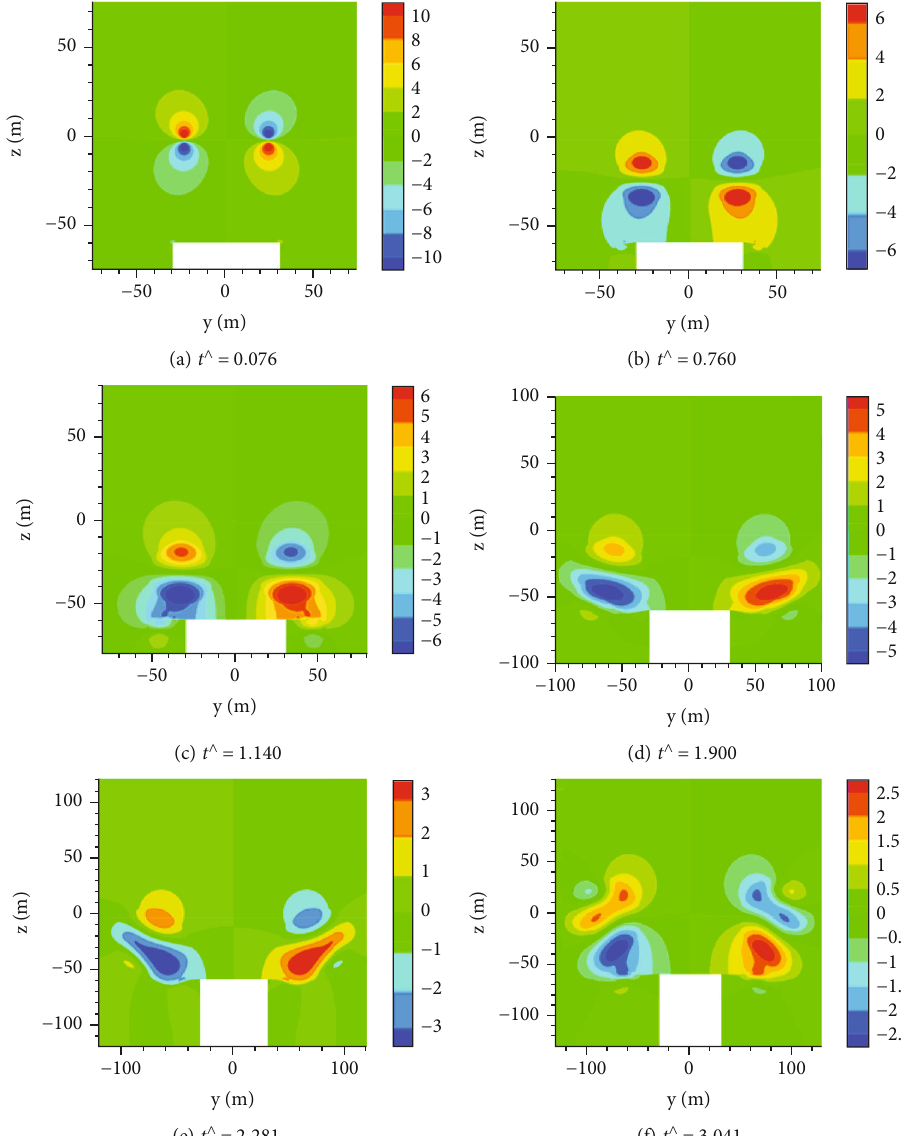
Figure 16: Contours of y velocity at di ff erent times when the wake is 60m above the